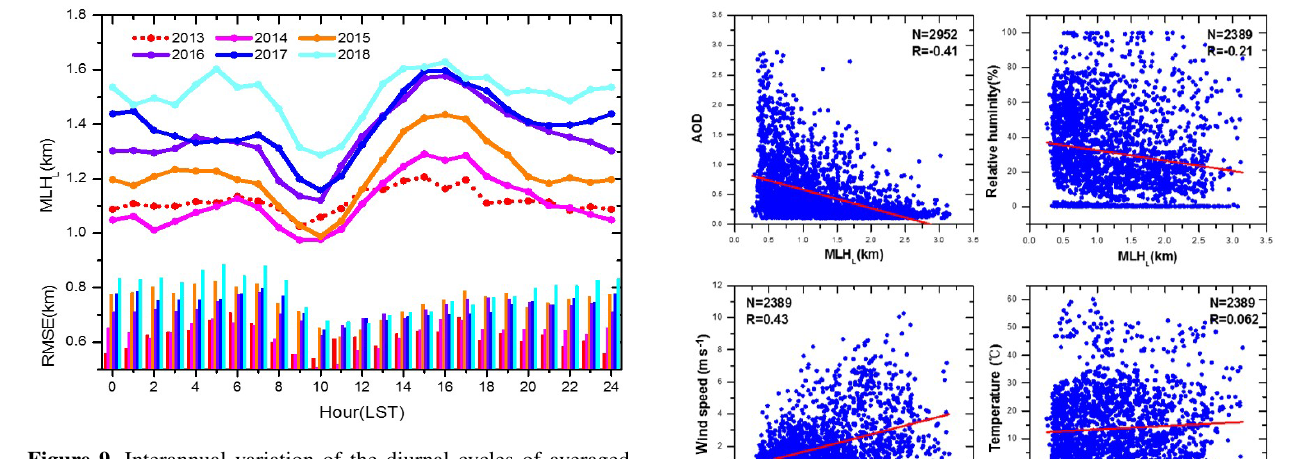
Figure 9. Interannual variation of the diurnal cycles of averaged MLH L retrieved from lidar (dot lines) and the standard deviation of MLH L (histograms). Due to the incomplete data for 2013, the MLH L data for 2013 are presented as a dotted line. Table 2. Statistics of boundary layer height interannual change.